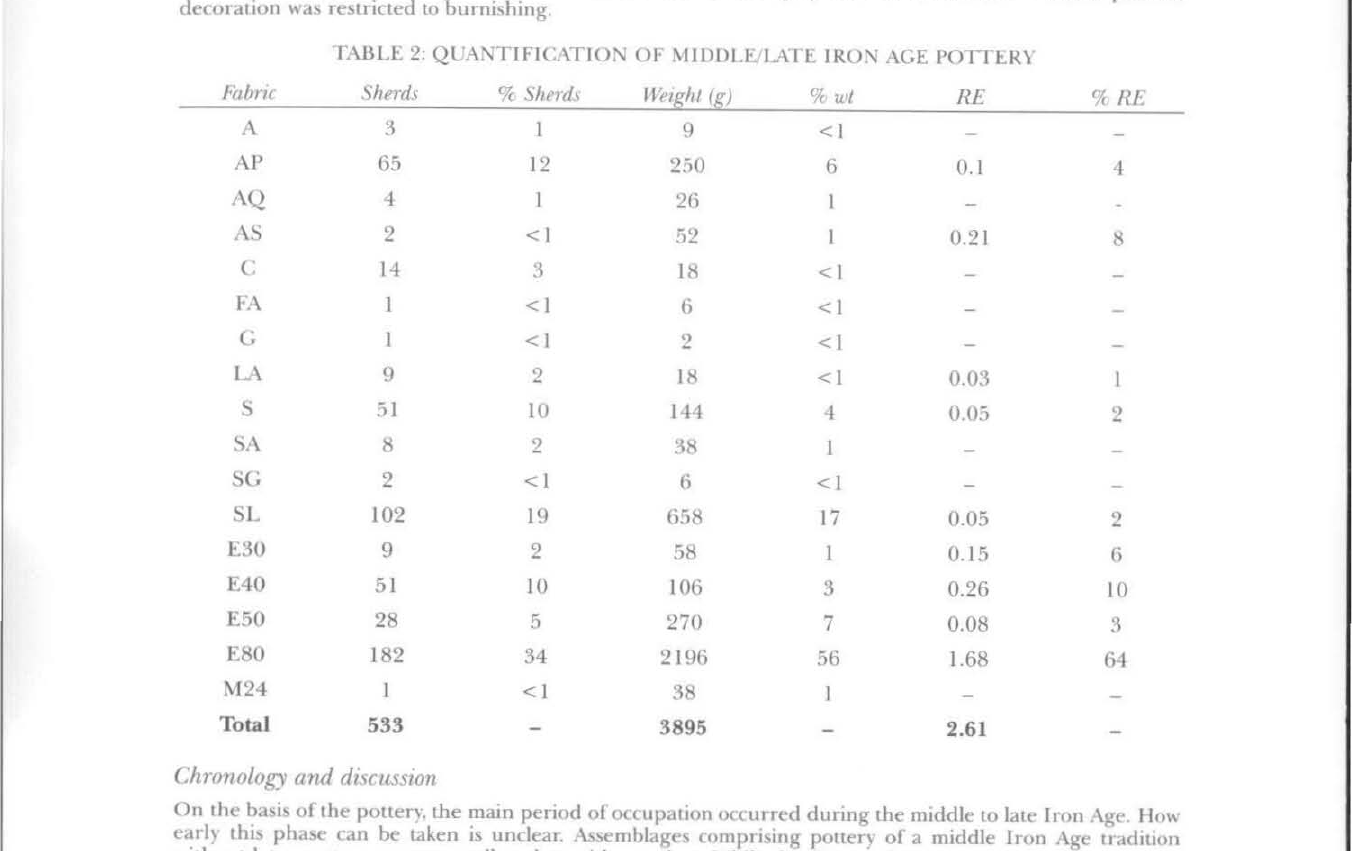
TABLE 2: QL'AI\TIFICATI01\ OF MIIlDLEoLAl E IRO'l AGE Po'nERY Fllbnc